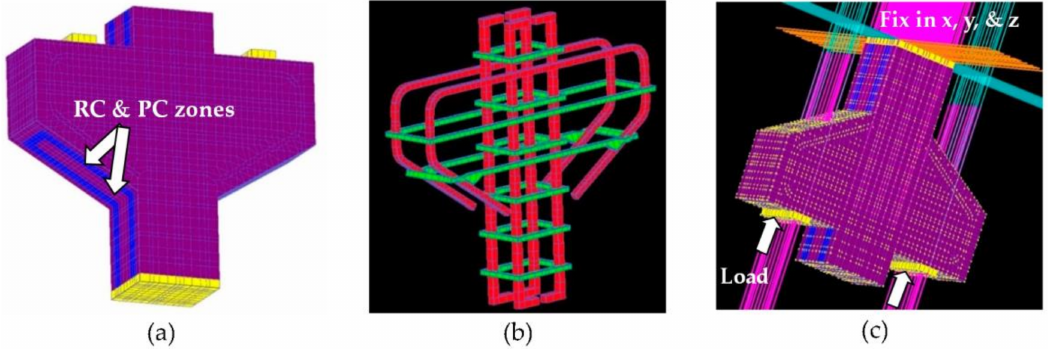
Figure 11. Details of numerical model: ( a ) 3D FE mesh model; ( b ) Reinforcement arrangement; and ( c ) Boundary